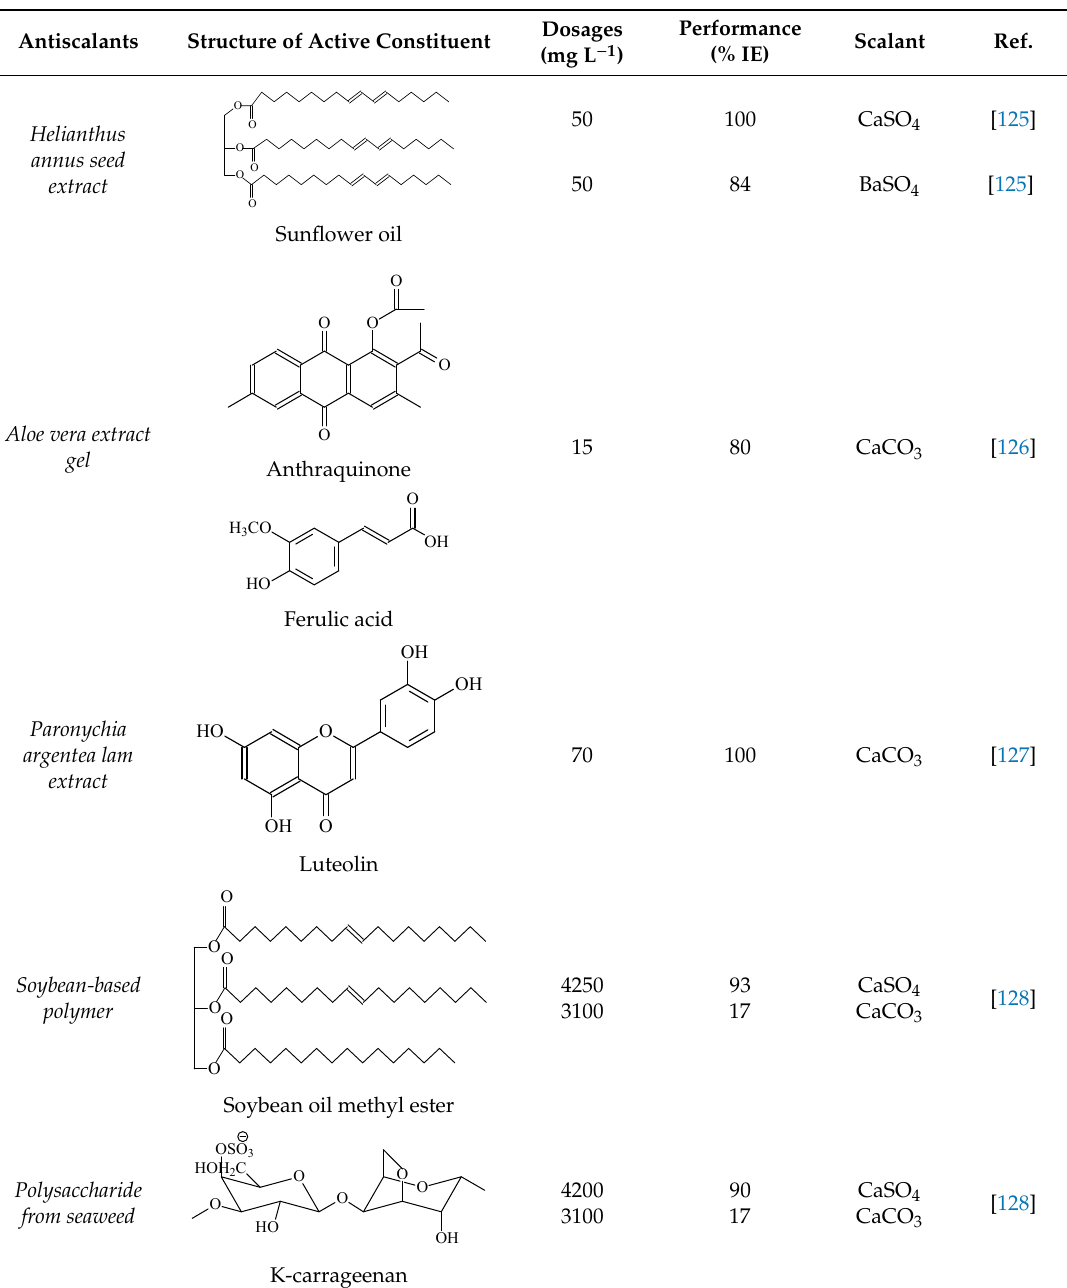
stock solution using the same process. The olive leaves are rich in phenolic molecules